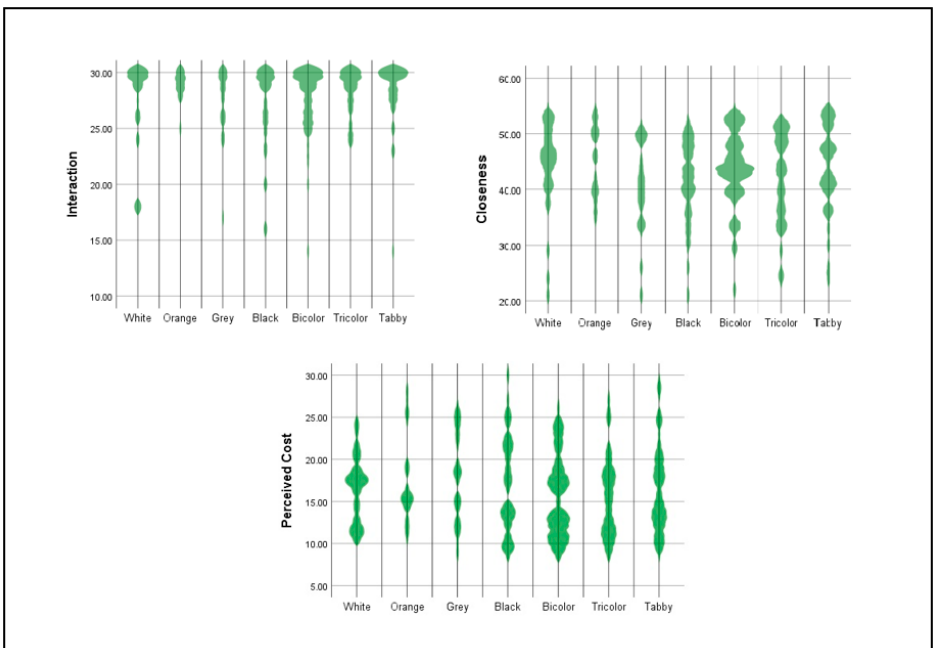
Figure 2. Cat colors and CORS subescales: individual distribution.